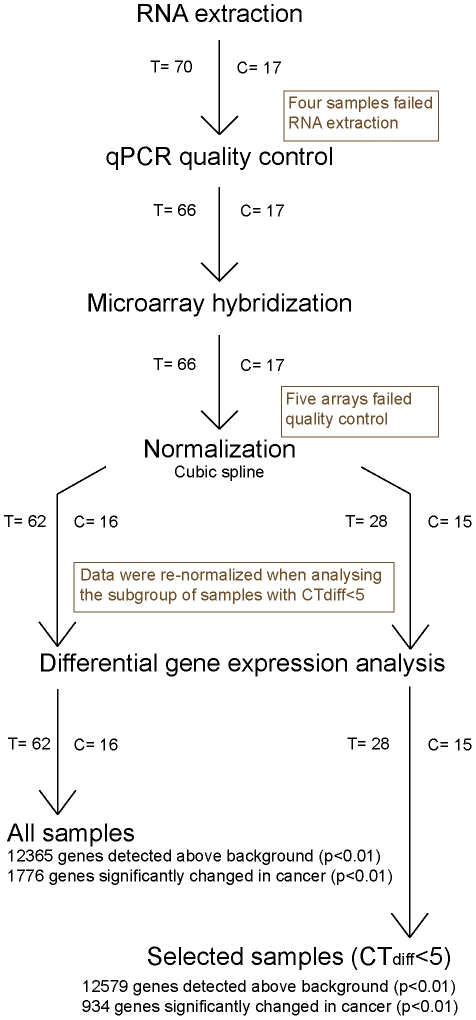
Flowchart illustrating experimental procedure.Description of the procedures used to assess samples from RNA extraction to acquiring of gene lists, including samples removed following each step of analysis. Tumour samples are abbreviated T and controls C.